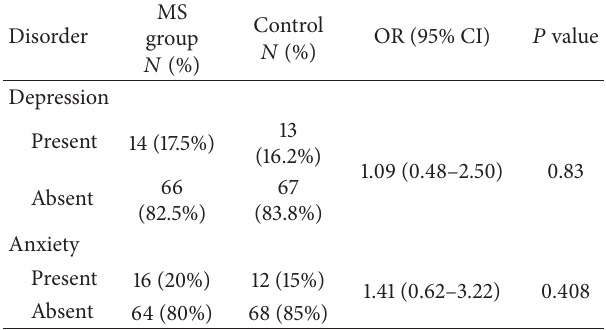
Table 4: MS and control